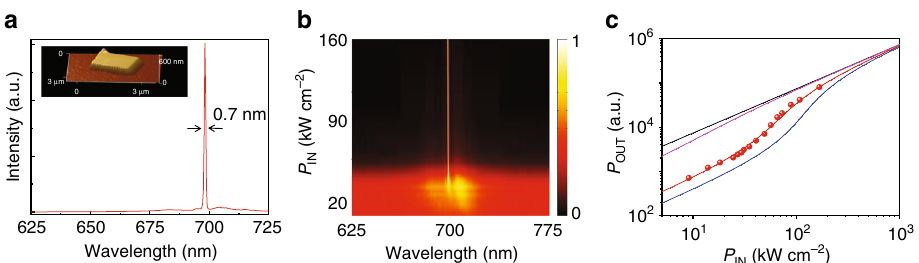
Fig. 2 Room temperature ultralow threshold plasmonic nanolaser. a Laser spectrum of a plasmonic nanolaser with a threshold of ~32 kW cm − 2 . Inset: atomic force microscope image of the device. b Spectra normalized to peak value vs. pump power highlighting the emergence of a dominant laser mode with reduced linewidth over the spontaneous emission. c Light – light curve of the plasmonic nanolaser (dots show data values). The spontaneous emission coupling ( β ) factor of the nanolaser is about 0.09 (red line). Black, pink, and blue lines are reference light – light curves corresponding to β = 1, β = 0.5, β = 0.05